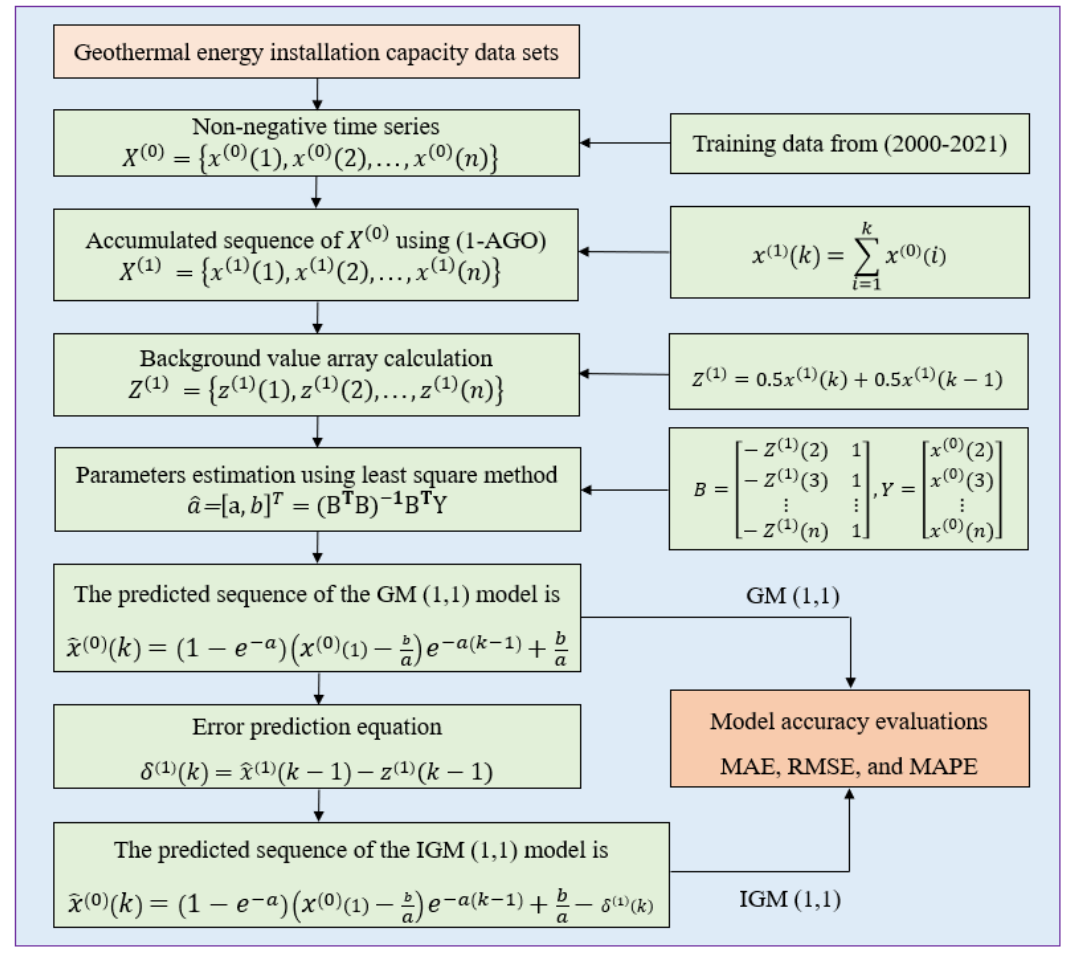
Figure 2. Schematic diagram of the IGM (1,1) model.